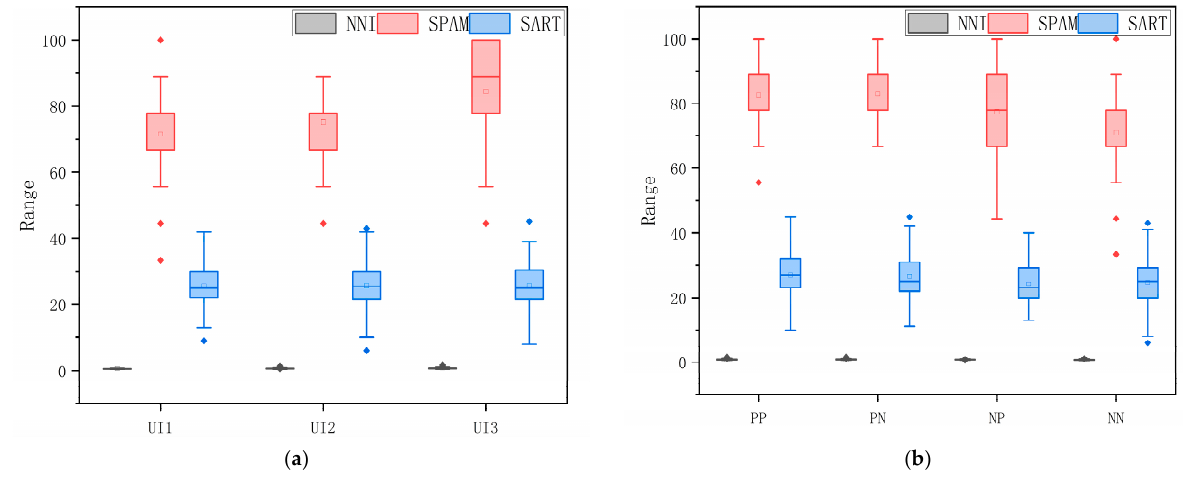
Figure 11. Correlation between NNI and SA scores obtained by SPAM and SART: ( a ) among UI levels; ( b ) among presentation frames.